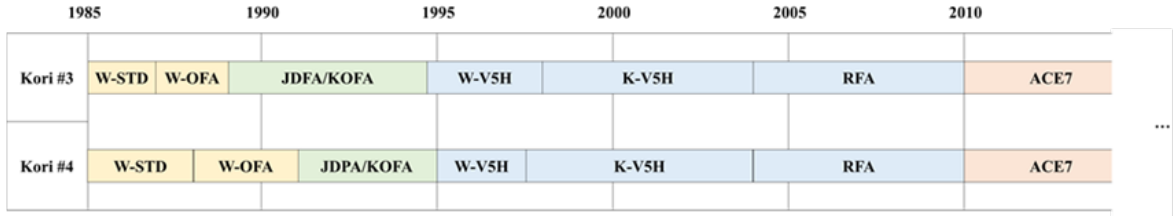
Table 8. Estimated total decay heat generation of Kori unit 4.